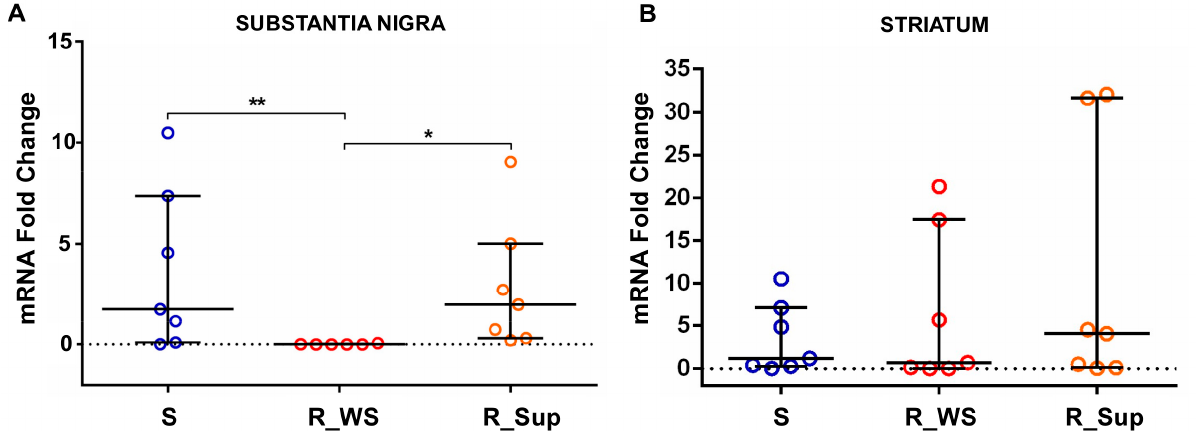
Figure 3. Differences in Kynu expression between the groups in the substantia nigra and striatum. ( A ) Kynu expression in rotenone-treated rats without supplementation (R_WS—median: 0.006, min: 0.002, max: 0.062, n = 6) is practically nonexistent when compared to the sham group (** p < 0.05, fold change = − 2.45). Those rotenone-treated rats that received the supplementation with folic acid and vitamin B12 (R_Sup—median = 1.97, min: 0.202, max: 9.05, n = 7) maintained the expression levels observed for the sham group (S—median = 1.74, min: 0.014, max: 10.49, n = 7), meaning that the rotenone-induced decrease in Kynu ’s gene expression was prevented in the supplemented group (R_Sup) (* p < 0.05, fold change = − 2.50). ( B ) There were no significant changes in Kynu expression between groups in the striatum. R_Sup—median = 4.05, min: 0.06, max: 32.06, n = 7; R_WS—median = 0.69, min: 0.03, max: 21.33, n = 7; S—median = 1.19, min: 0.02, max: 10.52, n = 7. Data are expressed as median (IQR). Min = minimum; max = maximum.